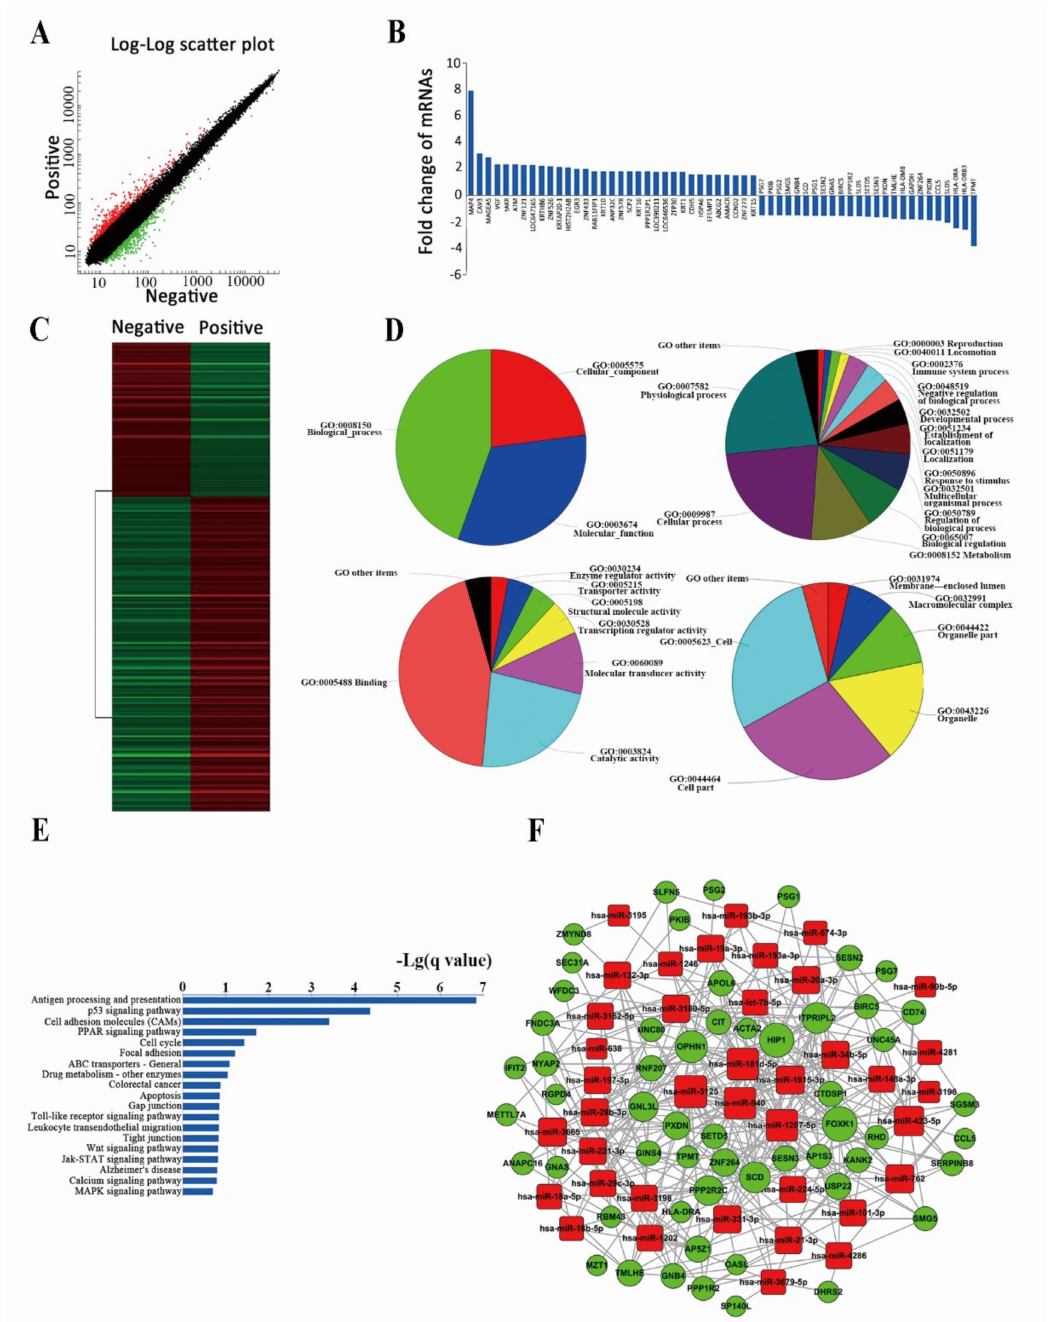
Figure 5. Analysis of di ff erently expressed mRNAs between two subpopulations of cells. ( A ) Scatter plot of di ff erently expressed mRNAs detected by microarray. ( B ) Partial di ff erently expressed mRNAs. Detailed data are listed in Table S2. ( C ) Distinct expressions between positive and negative subpopulations of cells revealed by clustering analysis. ( D ) GO analysis of the selected di ff erently expressedmRNAs. ( E )Pathwayanalysisfordi ff erentlyexpressedmRNAsinthetwocellsubpopulations. ( F ) Predicted miRNA-associated mRNA network participates in maintenance of cell